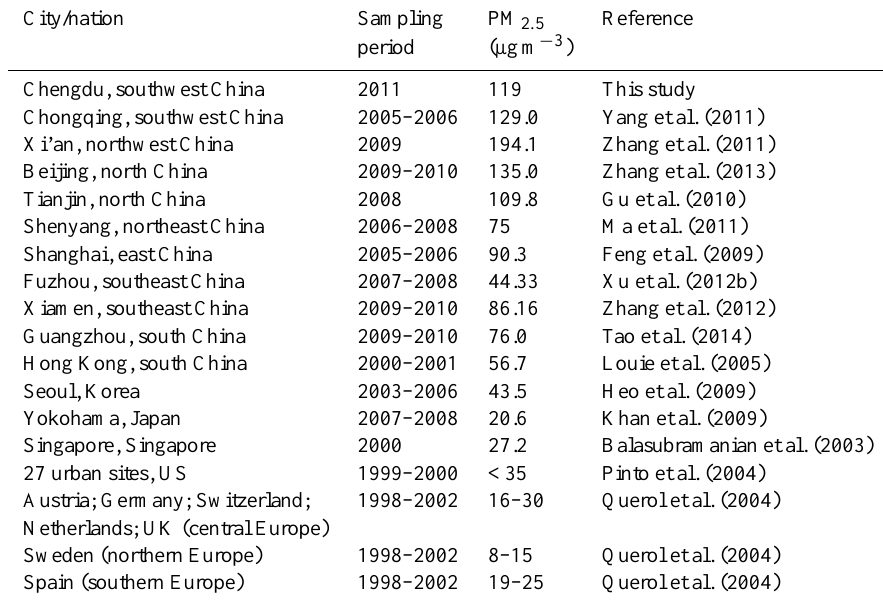
Table 1. Statistics of annual PM 2 . 5 mass concentrations in urban Chengdu and other cities in the world. City/nation Sampling PM 2 . 5 Reference